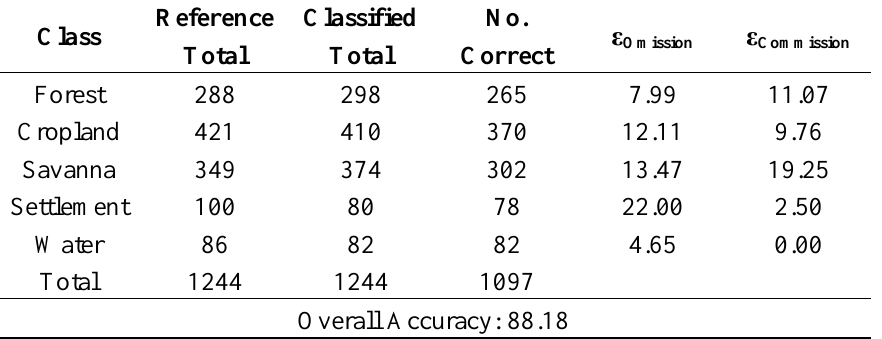
Table 5. Error assessment of combined thematic maps from Path: 071 Row: 072, Path: 072 Row: 072, and Path: 073 Row: 071. Errors of omission and commission are reported in the body of the table, overall accuracy at the